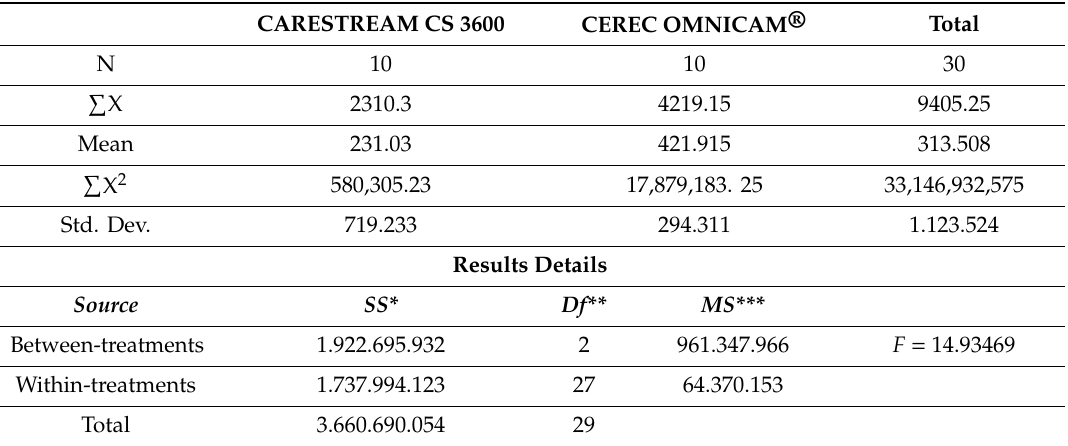
Table 2. Distance between reference lines and test ones in sample 1 with saliva.